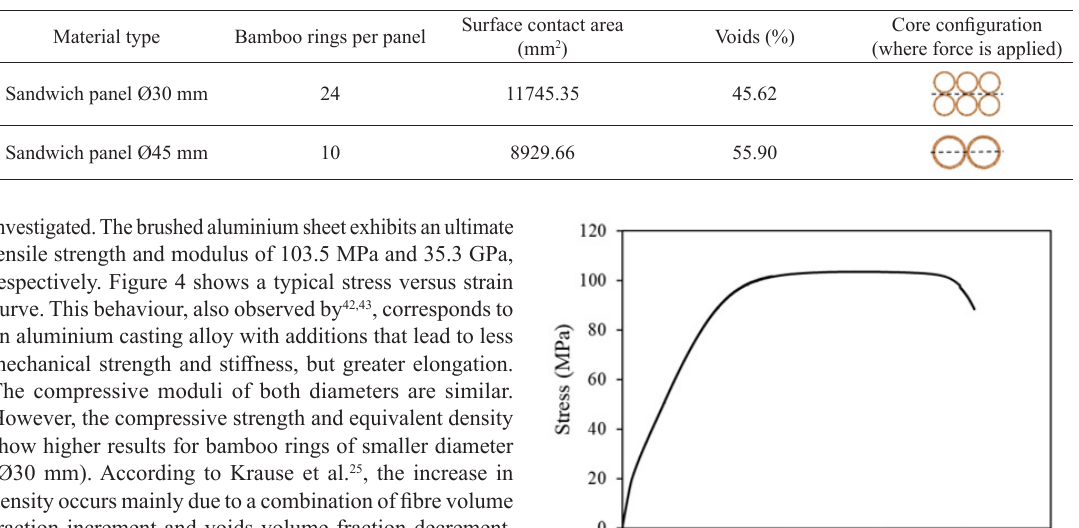
Table 4. Additional characteristics of sandwich